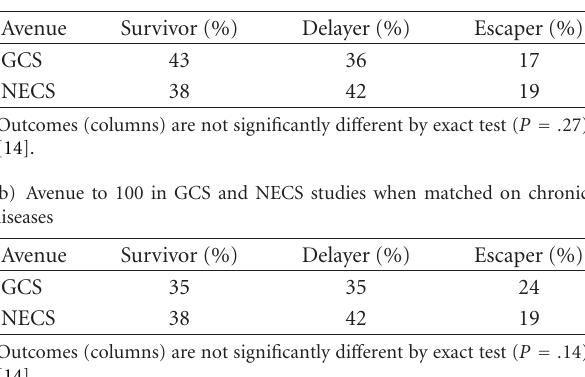
Table 3: Avenues by which we reach 100. Centenarians who first experience chronic disease before 80 are termed survivors. Cen- tenarians who first experience chronic disease in the interval 80– 98 years of age are termed delayers. Centenarians who experience chronic disease only at 98 or older are termed escapers. (a) Fraction of survivors, delayers, and escapers in the GCS [3] and NECS [4] studies. (b) Fraction of survivors, delayers, and escapers in the GCS and NECS studies when matched on the chronic diseases of NECS.